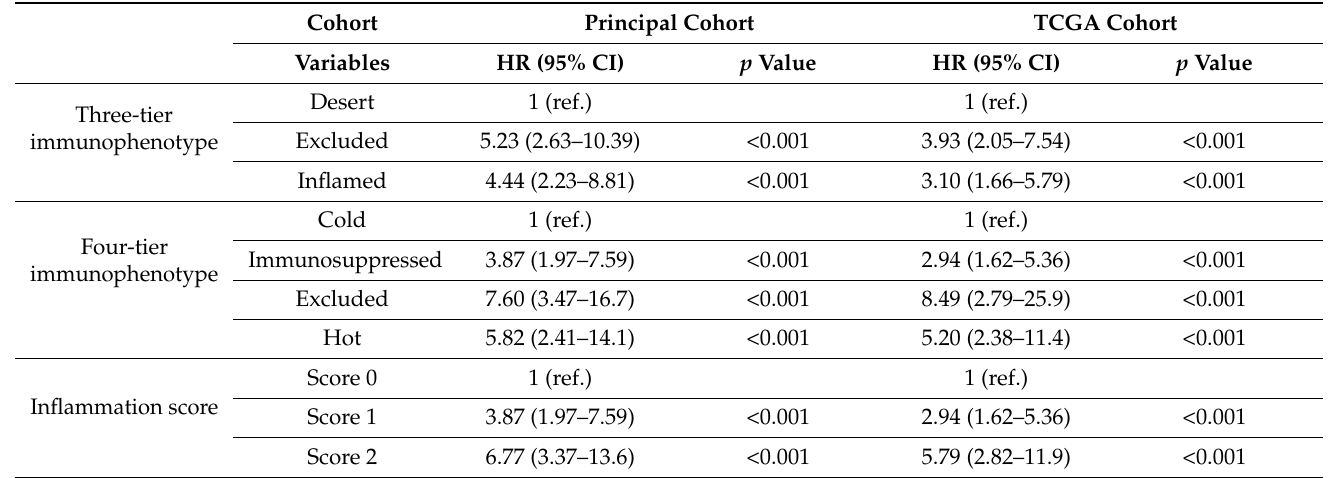
Table 3. Univariate associations with recurrence after nephrectomy in patients with clear cell renal cell